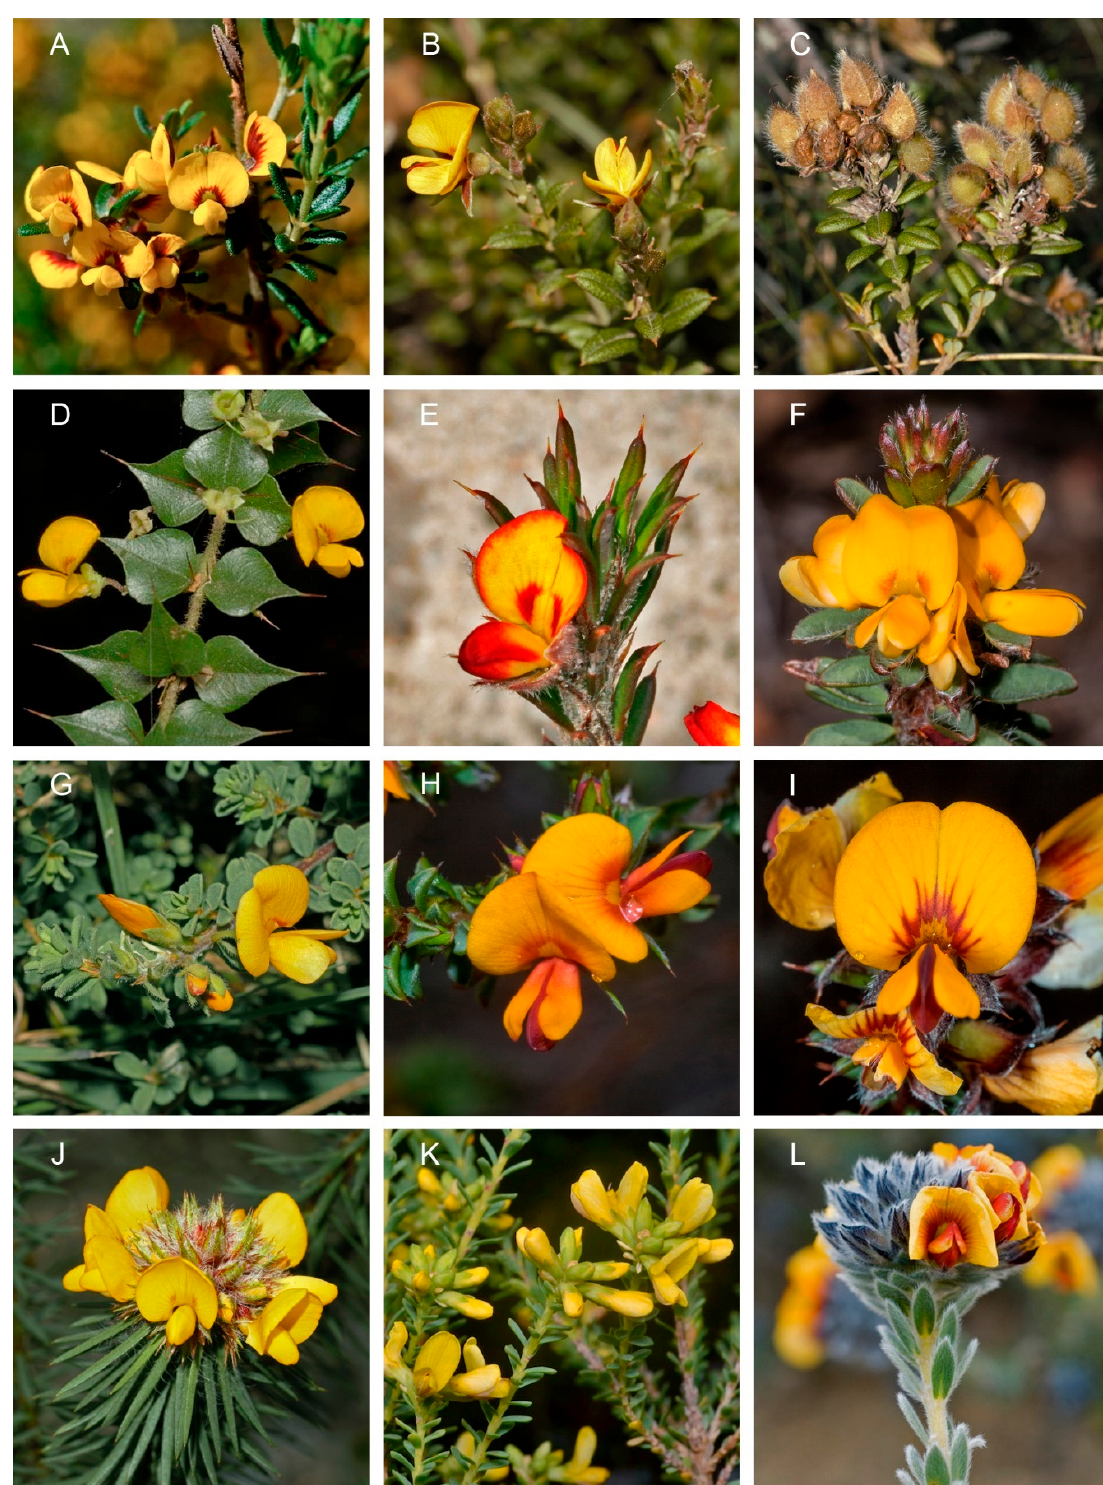
Figure 6. Morphological diversity of representative species from Fabaceae tribe Mirbelieae (core Mirbelieae). ( A ) Oxy- lobium cordifolium. ( B ) Oxylobium oxylobioides (flowering). ( C ) Oxylobium oxylobioides (fruiting). ( D ) Podolobium acicuiliferum . ( E ) Pultenaea brachyphylla . ( F ) Pultenaea ferruginea . ( G ) Pultenaea maritima . ( H ) Pultenaea procumbens . ( I ) Pultenaea sp. Olinda . ( J ) Pultenaea stipularis . ( K ) Stonesiella selaginoides . ( L ) Urodon dasyphyllus . Photographs by Russell Barrett except ( A , D , K , L ) by Murray Fagg (( A , D , K , L ) from the Australian Plant Image Index: http://www.anbg.gov.au/photo (accessed on 11 June 2021)).